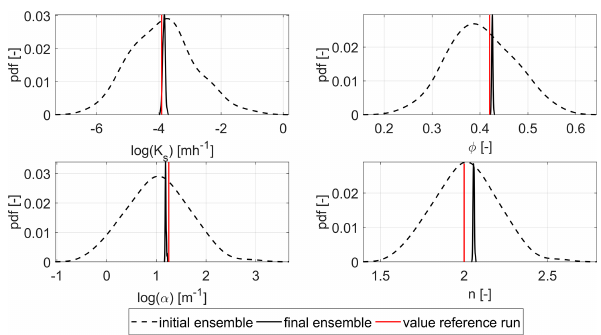
Figure 6. Probability density functions (pdf’s) of the parameters for the homogeneous scenario and the joint update of all